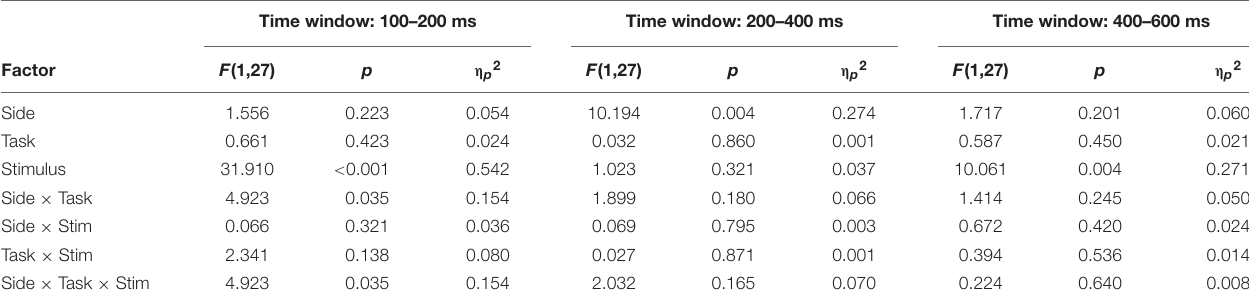
TABLE 1 | Rm-ANOVA analysis of the electrophysiological effects. Time window: 100–200 ms Time window: 200–400 ms Time window: 400–600